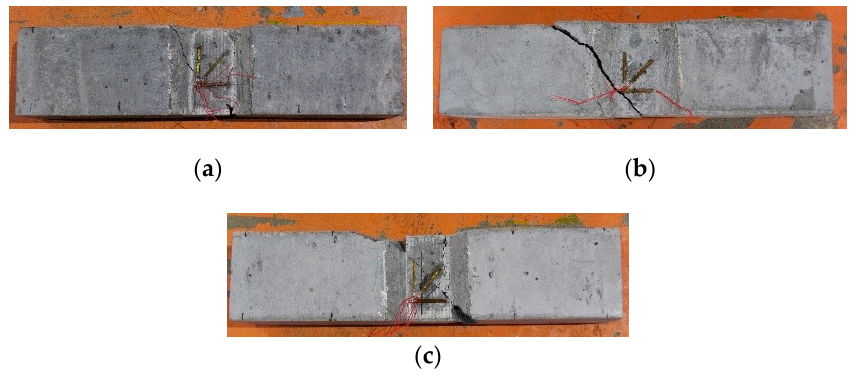
Figure 11. The shear failure morphology of LWACs: ( a ) plain sample, ( b ) sample with BF, ( c ) sample with PANF.